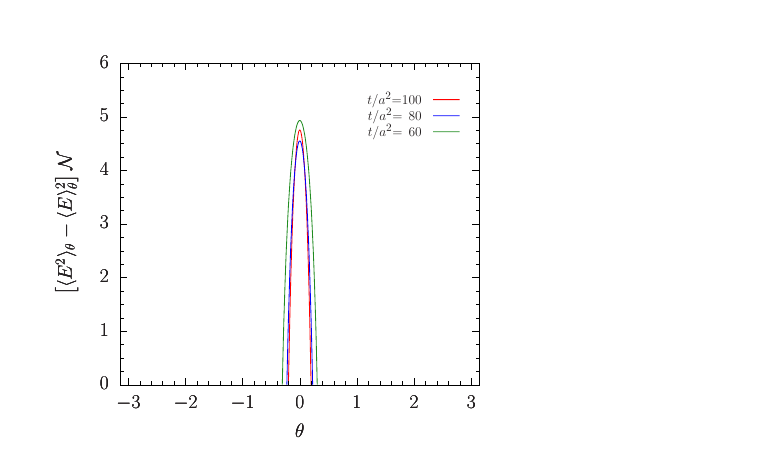
Figure 9: The connected glueball correlator on the 24 4 lattice for various flow times.